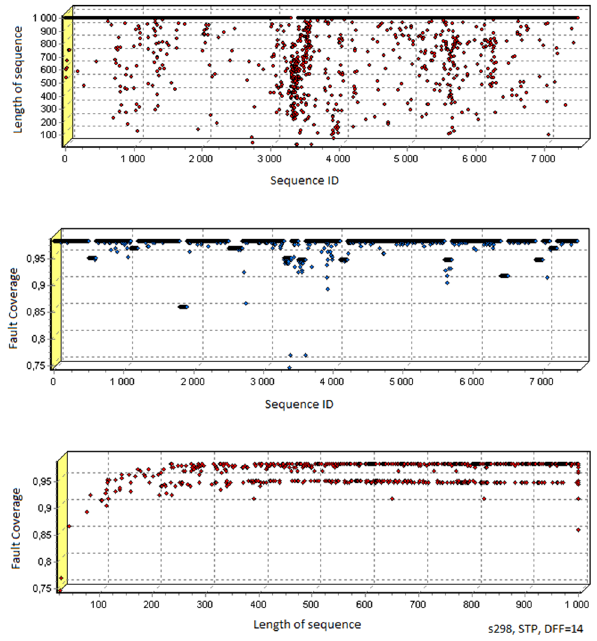
Fig. 33 STP for s298 with use of 12 internal flip-flops